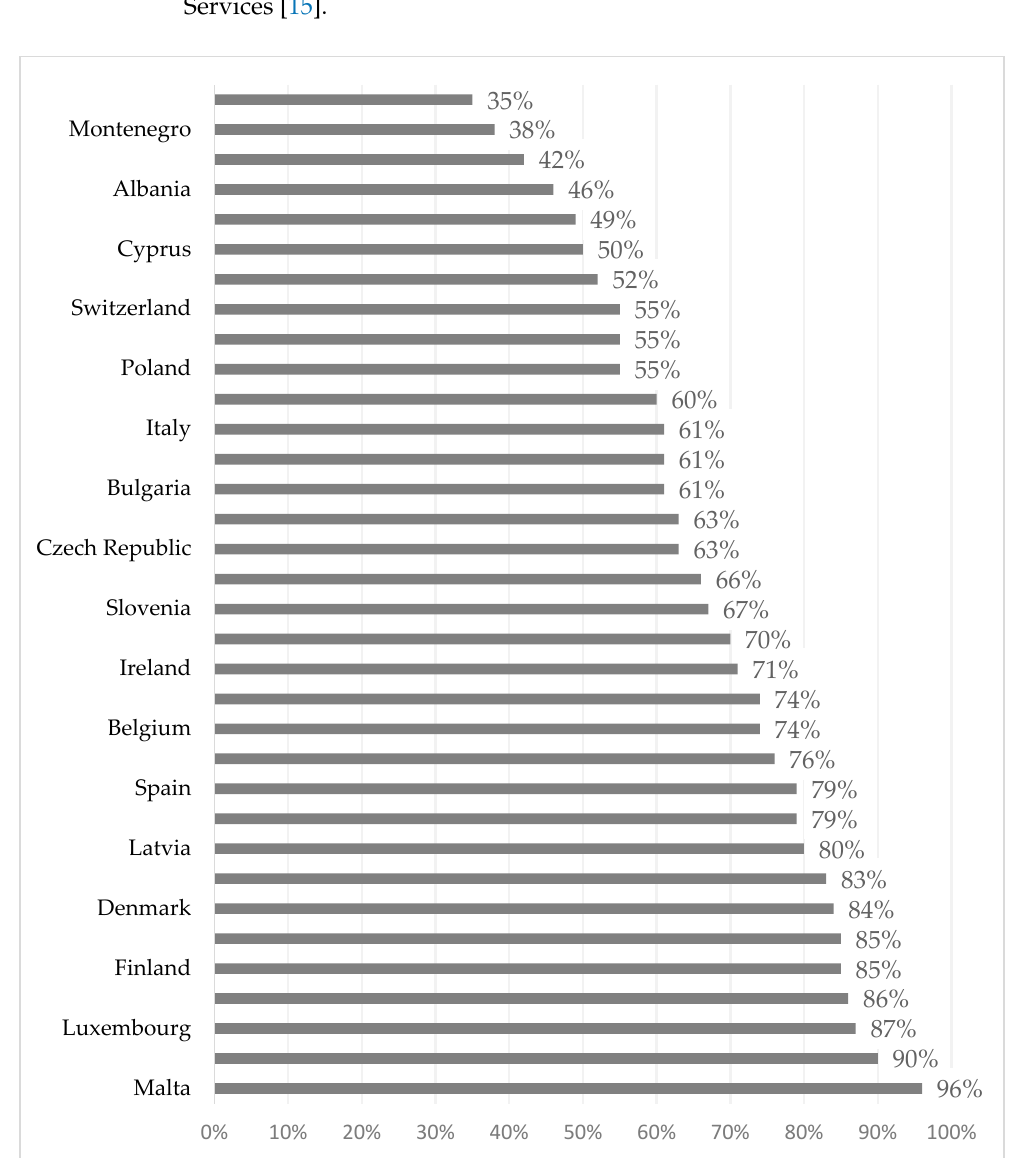
Table 5. Literature review on digitization and e-Government.